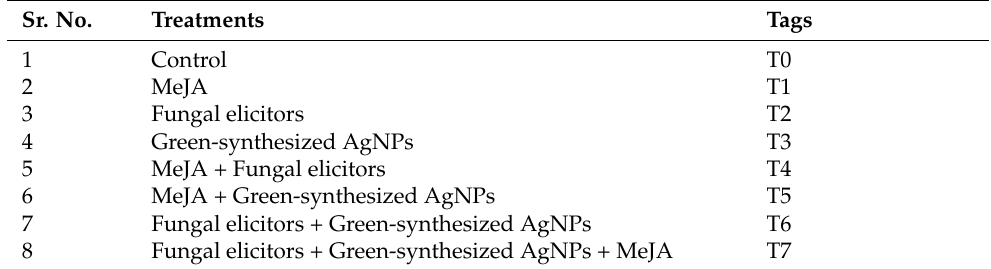
Table 1. All the treatments with tags used for the experiment. Sr.